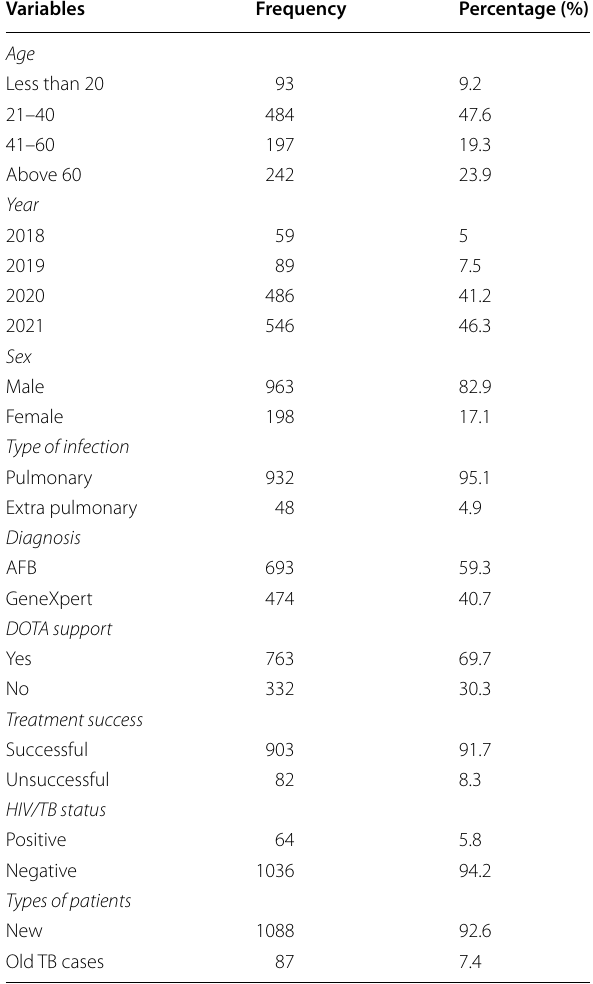
Table 1 Socio-demographic and clinical characteristics of TB